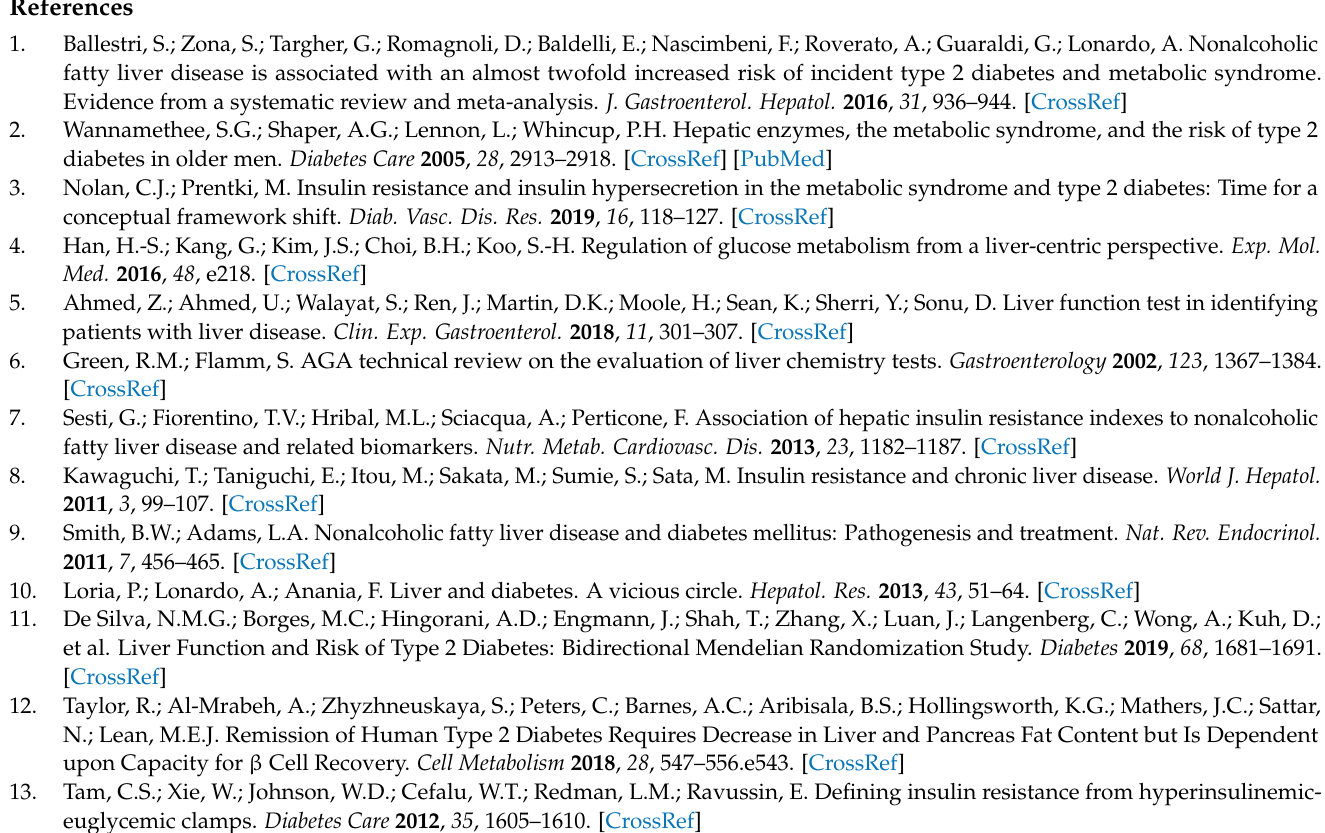
principal component analysis. Table S2: Multivariable linear regression of liver function tests according to individual fasting blood glucose, triglyceride, and HDL-C levels. Table S3: Multivariable adjusted linear regression for liver function tests based on TyG index and TG/HDL-C ratio. Table S4: Multivariable adjusted logistic regression for abnormal liver function in different subgroups according to quintiles of TyG index and TG/HDL-C ratio. Figure S1: Linear prediction of TyG index with serum liver function. Figure S2: Linear prediction of TG/HDL-C ratio with serum liver